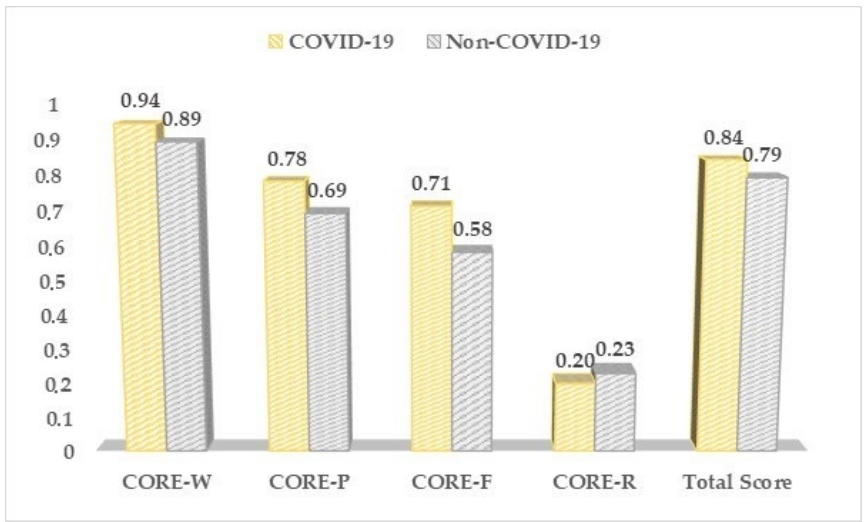
Figure 4. CORE-OM questionnaire results between COVID-19 positive and negative pregnant women.